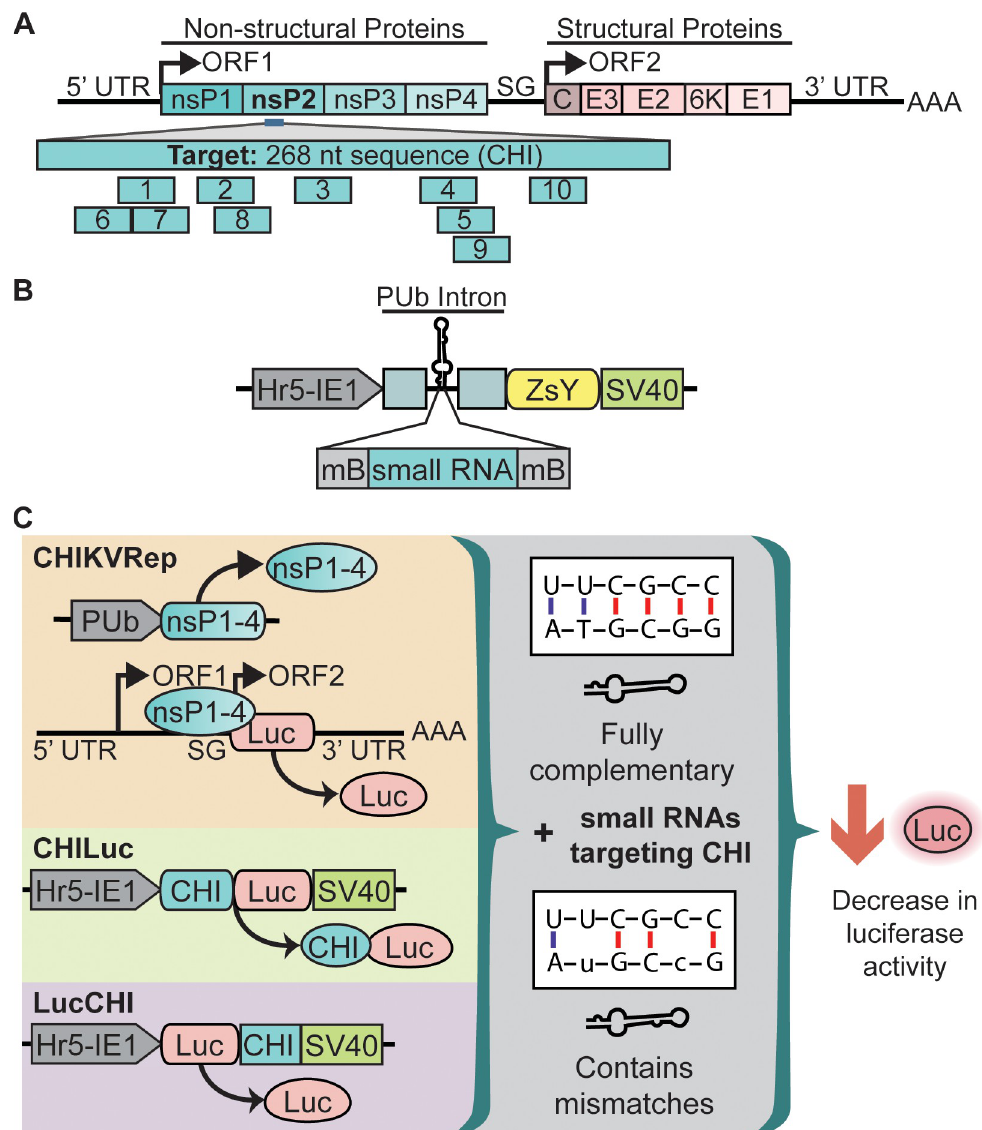
Fig 1. Experimental designs. (A) Schematic of the CHIKV genome and the location of the 268 nt nsP2 target region (CHI) and each of the 10 sites targeted by small RNAs. (B) Schematic of small RNA expressing plasmids. (C) Strategy for testing small RNA mediated suppression of a CHIKV split replication system (CHIKVRep, replication complex nsP1-4 and viral reporter), chimeric firefly luciferase reporter (CHILuc) and synthetic reporter with the target sequence in the 3’ UTR (LucCHI). Small RNAs containing sequence mismatches (nt 2 and 11) or fully complementary sequences were assessed for their ability to target viral sequences in mosquito cell lines. AAA: polyadenylation signal, Hr5-IE1: Autographa californica nuclear polyhedrosis virus homologous region 5 enhancer-immediate-early gene 1 promoter, Luc: luciferase, mB: Drosophila melanogaster pre- miRNA-1 miRNA backbone, nt: nucleotide, ORF: open reading frame, PUb intron: Ae . aegypti polyubiquitin gene intron, SG: CHIKV subgenomic promoter, SV40: simian virus 40 polyadenylation signal, UTR: untranslated regions, ZsY: ZsYellow fluorescent protein. For the CHIKVRep split-replication system we used plasmids Ubi-P1234-CHIKV (pCHIKVRep2) and AGG1521:pCHIKVRep1 [13,17–19]. Plasmid Ubi-P1234-CHIKV (pCHIKVRep2) provides the replicase complex, while plasmid AGG1521:pCHIKVRep1 con- tains the subgenomic promoter, and nanoluciferase (NL) replacing the structural proteins.